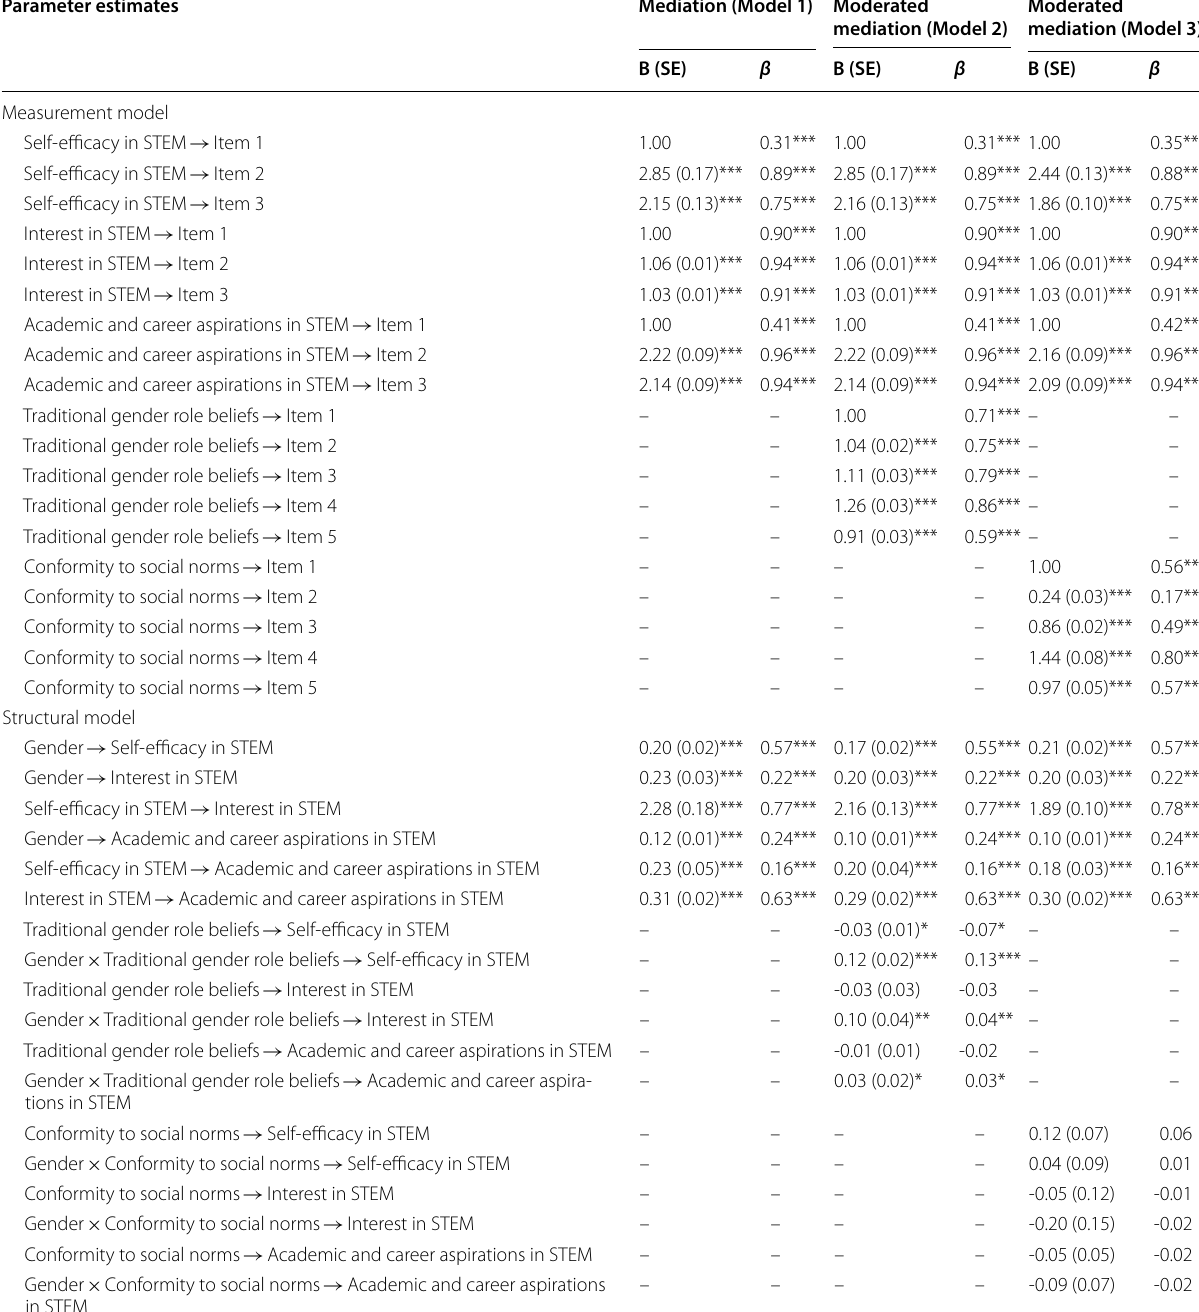
Table 3 Unstandardized and standardized path coefficients of mediation model and moderated mediation model